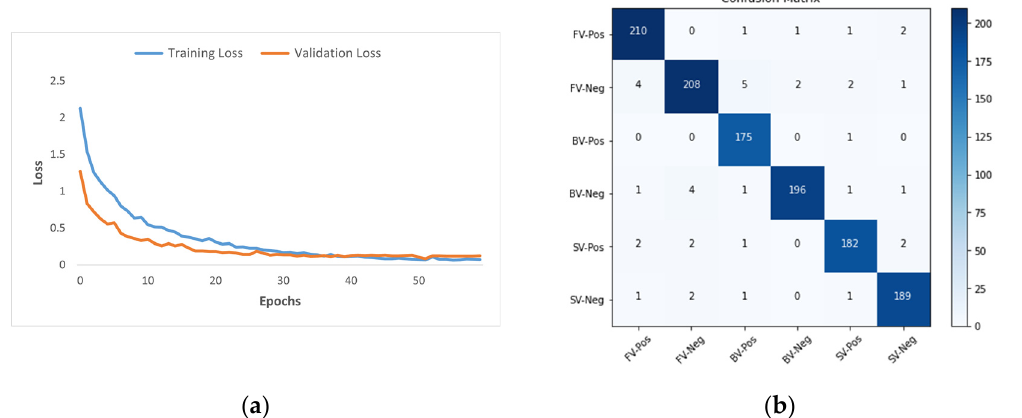
Figure 12. The loss curve and confusion matrix of multi-classification on INRIA and MSMT17 datasets: ( a ) The loss curve, ( b ) the confusion matrix.